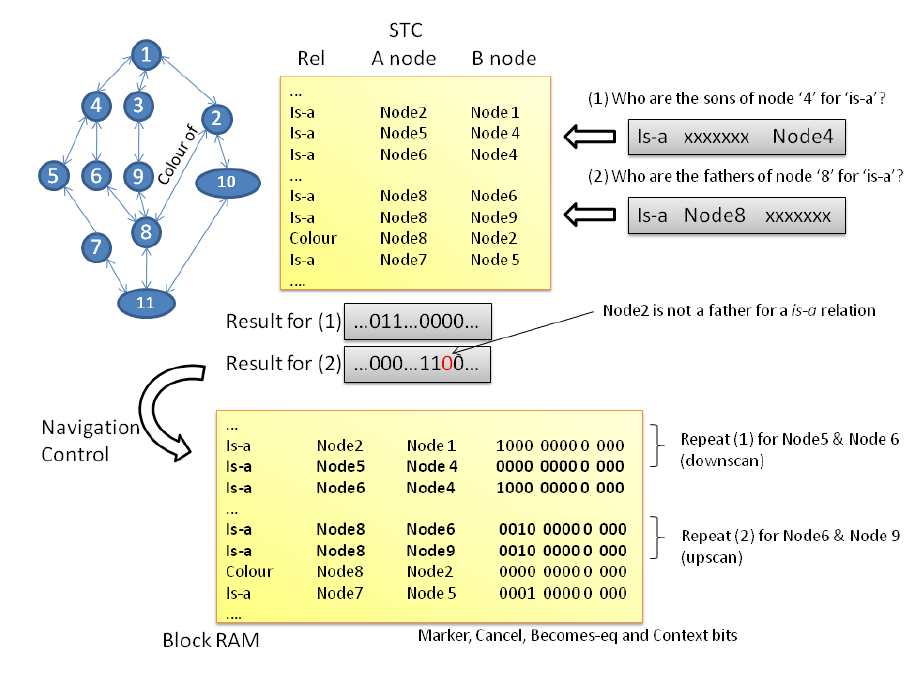
Figure 5. Memory content and basic tree search